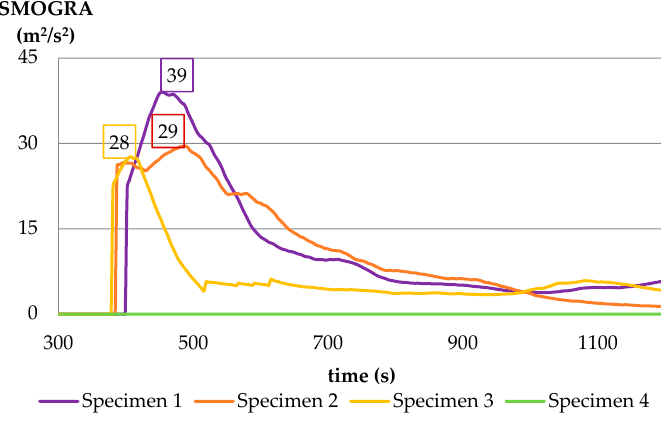
Figure 5. Smoke production rate (SMOGRA) results as a function of time of the test.